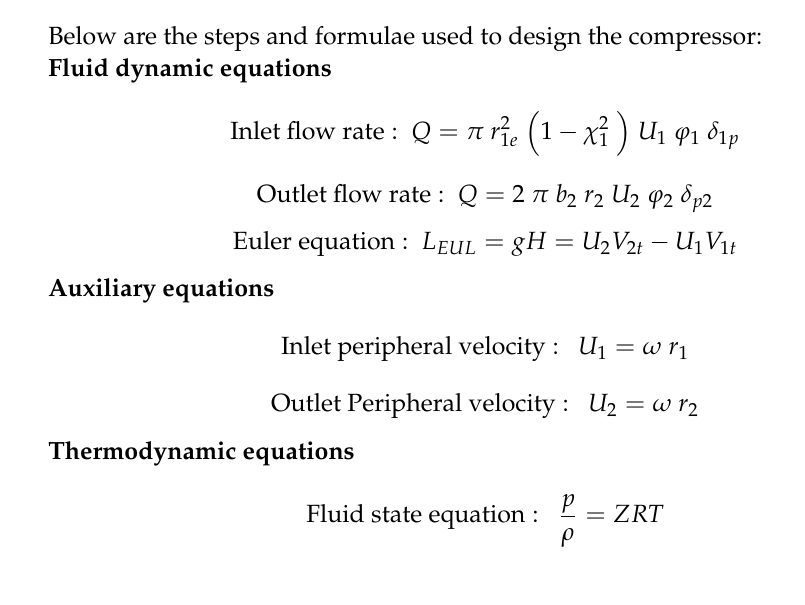
Figure 1. Rotor channel tracking.